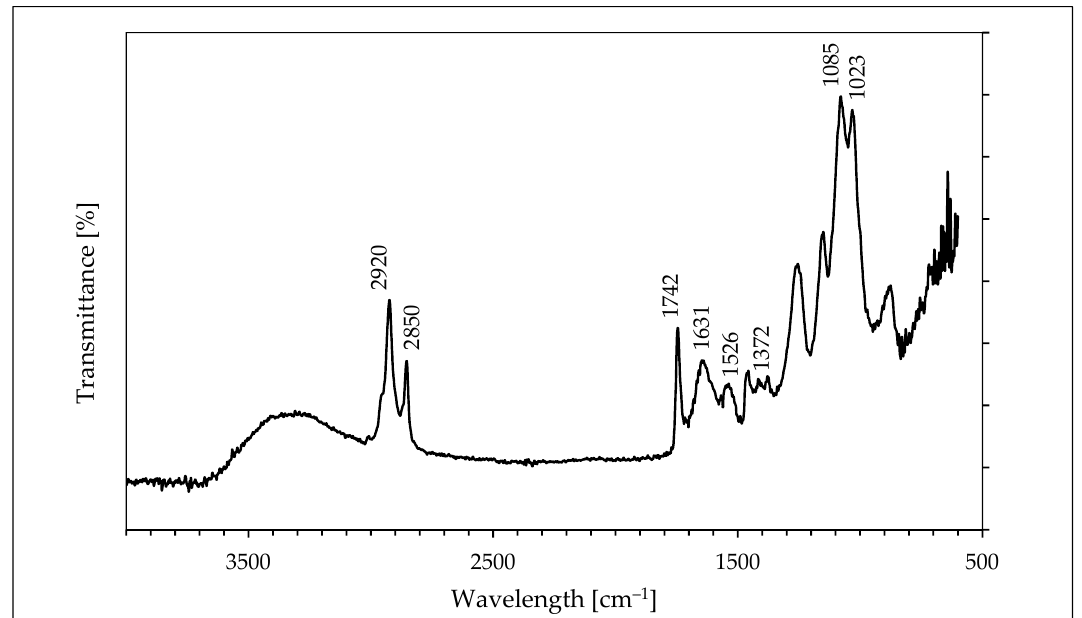
Figure 2. FTIR spectrum of the gold nanoparticles synthesized by the cell-free filtrate of Coriolus versicolor . The peaks at 1085 cm − 1 and 1024 cm − 1 correspond to P − OH and P − O − C stretching,